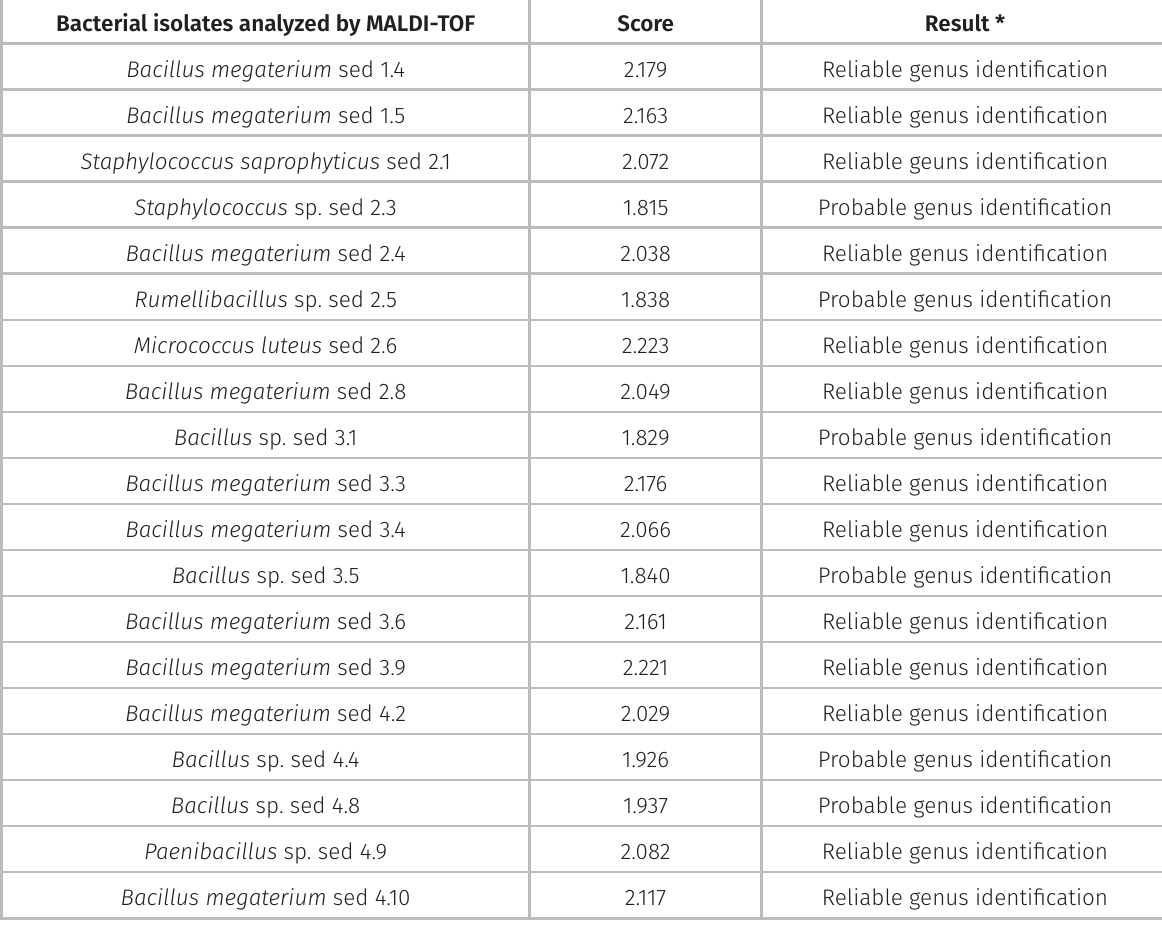
Table III. Bacterial isolates analyzed by MALDI-TOF, using the Biotyper 4.0 database and MBT OC software. Bacterial isolates analyzed by MALDI-TOF Score Result